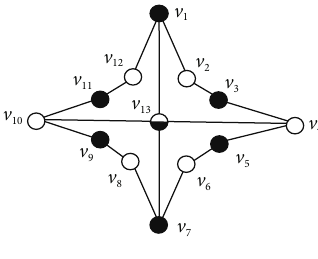
Figure 3: Jahangir graph J Table 2: Shows the distance sequence in Jahangir graph J